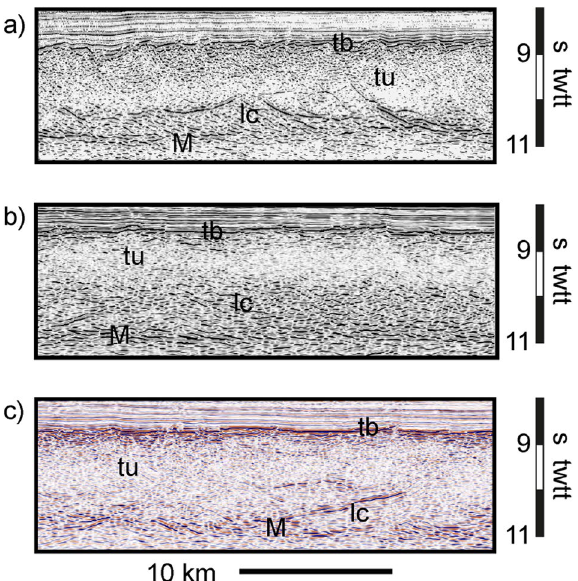
Figure 3. Seismic structure of the oceanic crust for three profiles alongside the South American margin (SAM5, SAM8 and SAM11 from top to bottom). tb indicates the reflective top of basement, tu the transparent unit in the upper crust, lc the more reflective lower crust and M the set of horizontal reflectors interpreted as the oceanic Moho at the base of the crust. The location of these profiles is shown in Fig. 2 (the numbering of the profiles is increasing southward). Courtesy of ION Geophysical.